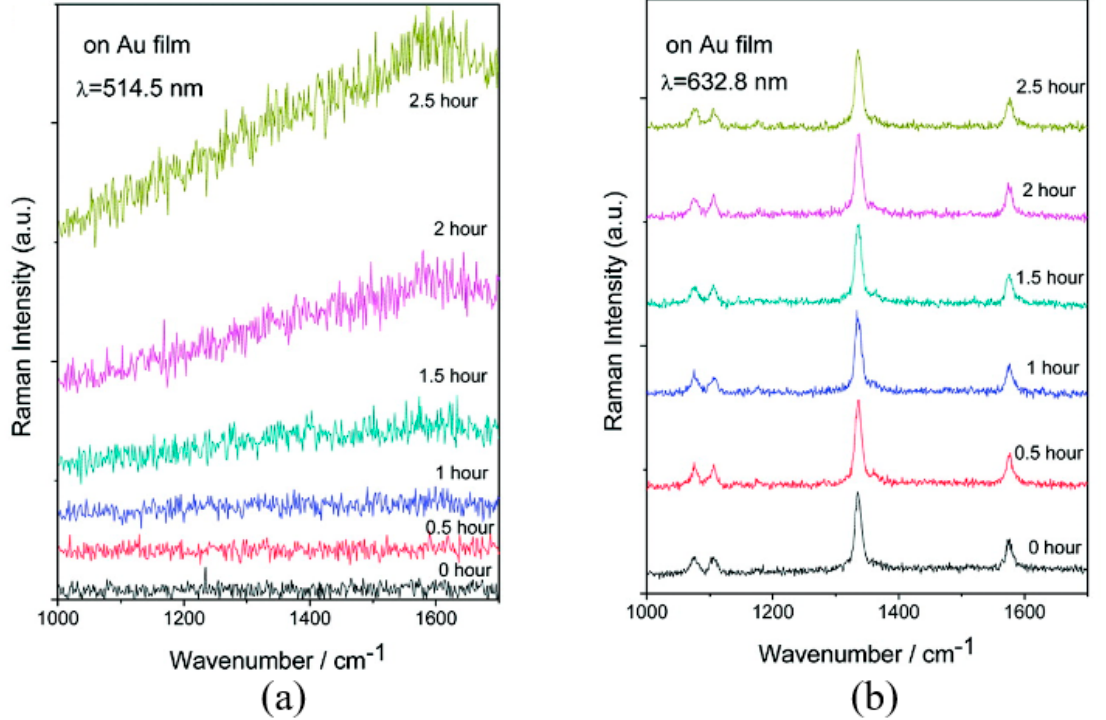
Figure 3. Surface-enhanced Raman scattering (SERS) spectra of 4NBT at the junction of an Ag nanoparticle (NP) on the Au film at incident wavelengths of ( a ) 514.5 nm and ( b ) 632.8 nm [29]. Catalysts 2019 , x , x FOR PEER REVIEW